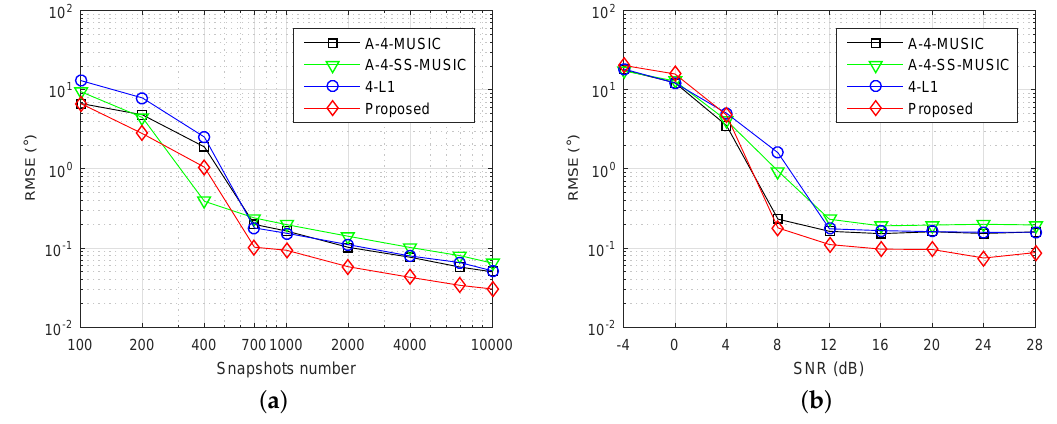
Figure 6. RMSE performance of four methods in the underdetermined case, S = { 1,2,4,11,25 } × d , K = 6, r = 0.1 ◦ , ( a ) SNR = 20 dB, ( b ) snapshots number is L =